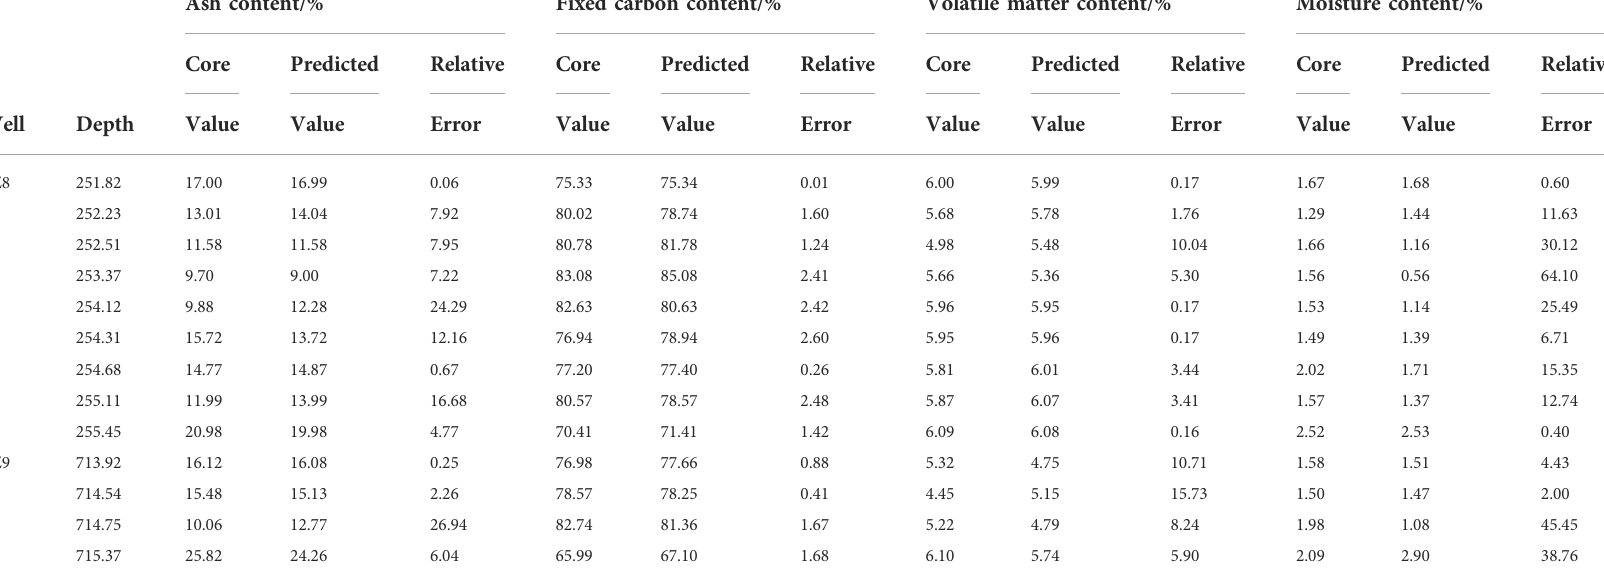
TABLE 5 Calculated and experimental values from wells of PZ8 and PZ9. Ash content/% Fixed carbon content/% Volatile matter content/% Moisture content/% Core Predicted Relative Core Predicted Relative Core Predicted Relative Core Predicted Relative Well Depth Value Value Error Value Value Error Value Value Error Value Value Error PZ8